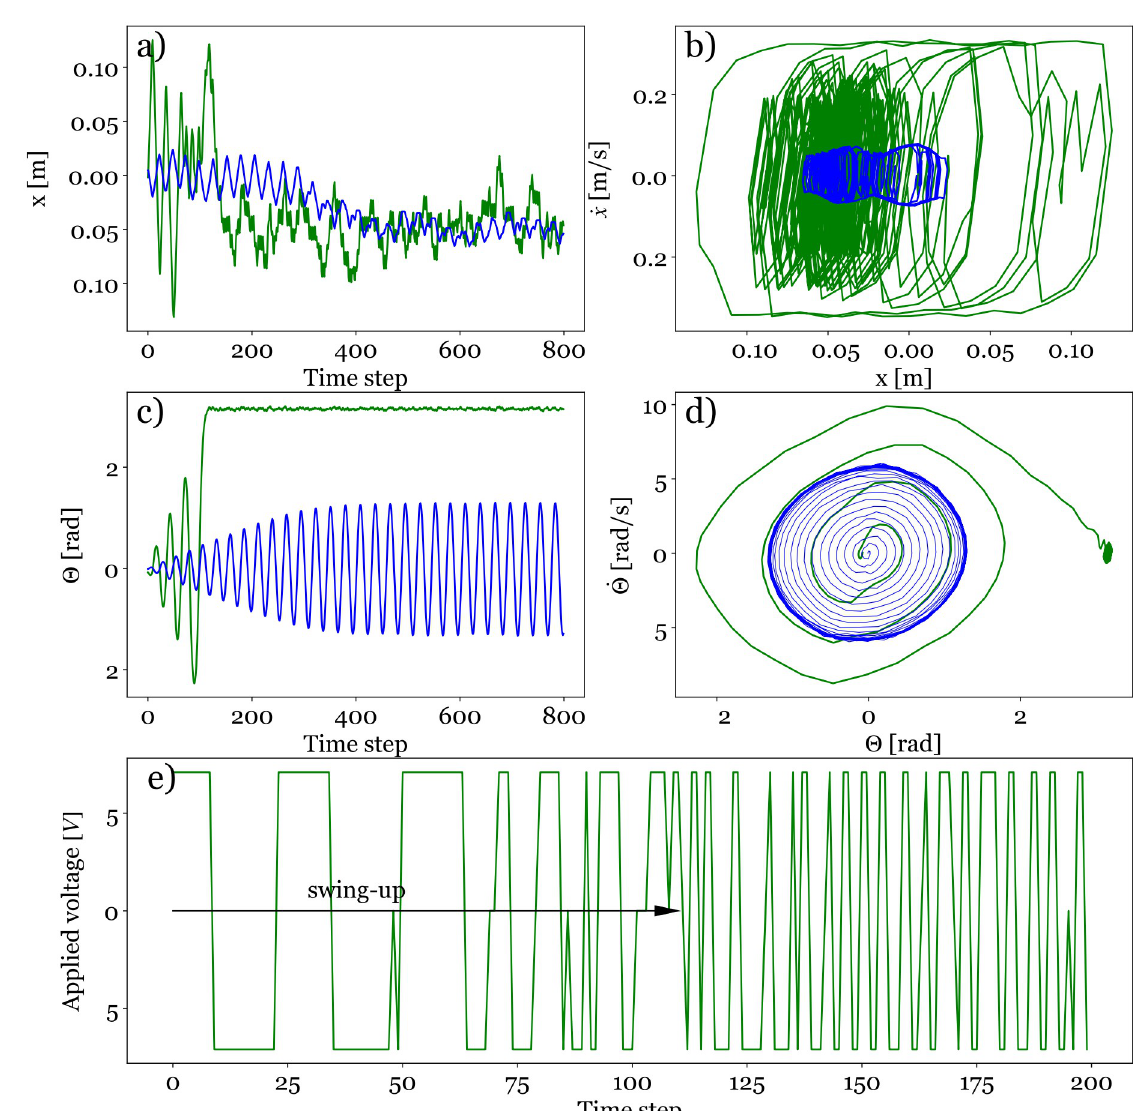
Fig 5. Experimental results with the best policies in inference for two different applied voltages U = 2.4 V (blue) and 7.1 V (green): a) Temporal evolution of the cart’s position x during one episode b) trajectory of the cart in the ð x ; _ x Þ space c) Temporal evolution of the pendulum’s angle θ during one episode d) Trajectory of the pendulum in the ð y ; _ y Þ space e) Temporal evolution of the applied voltage during the first 200 time